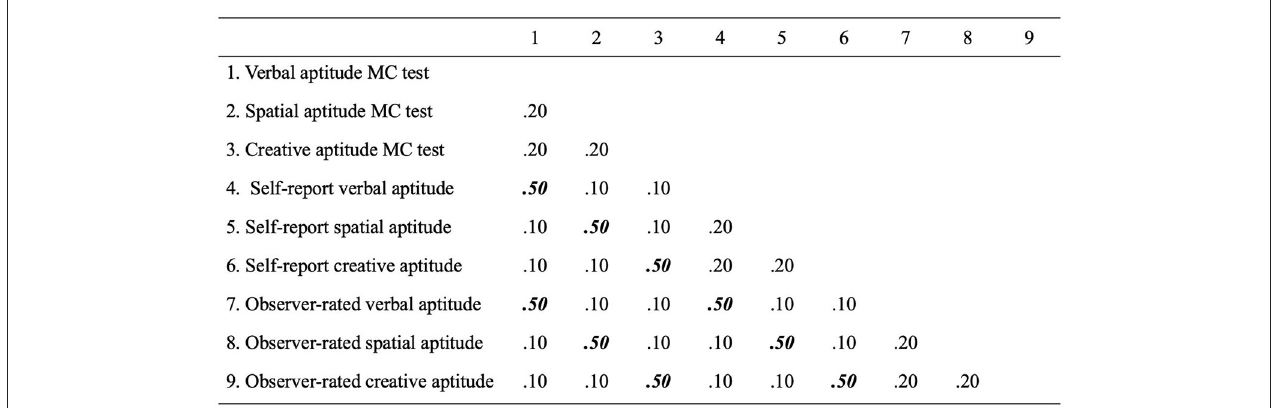
FIGURE 1 | Example multi-trait multi-method (MTMM) matrix with measures of cognitive and creative aptitudes. Correlations in bold and italics represent convergent validity estimates between different methods of measuring a shared construct (0.50). Divergent validity can be determined by comparing the same trait—different method correlations with the correlations among different trait—different method (all shown as 0.10) and different trait—same method combinations (all shown as